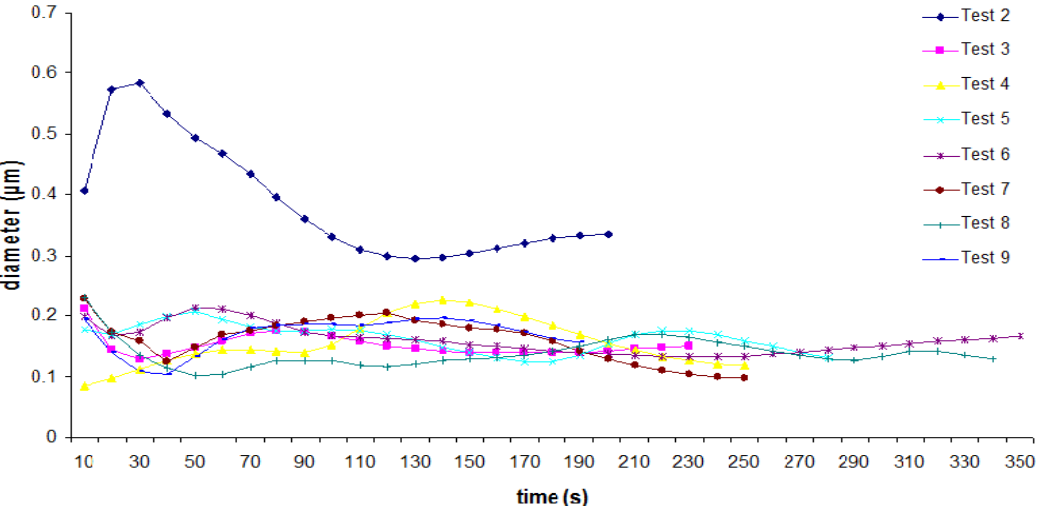
Figure 6. Variation in the average diameter ( μ m) of the PM period in the experiments conducted in